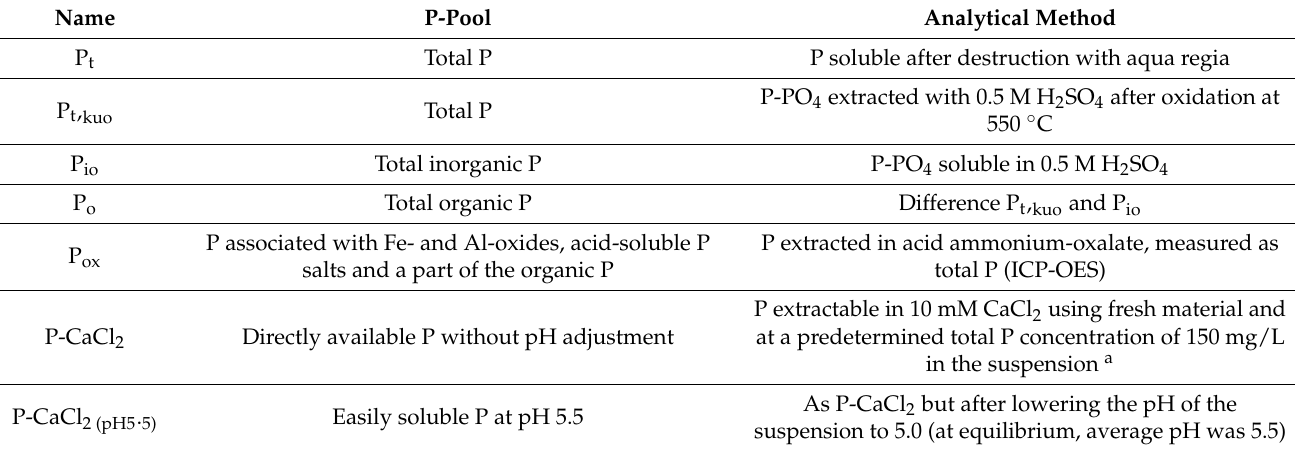
Table 2. Overview of the P pools and associated analytical methods used to assess P speciation in the solid organic fertilisers. Name P-Pool Analytical